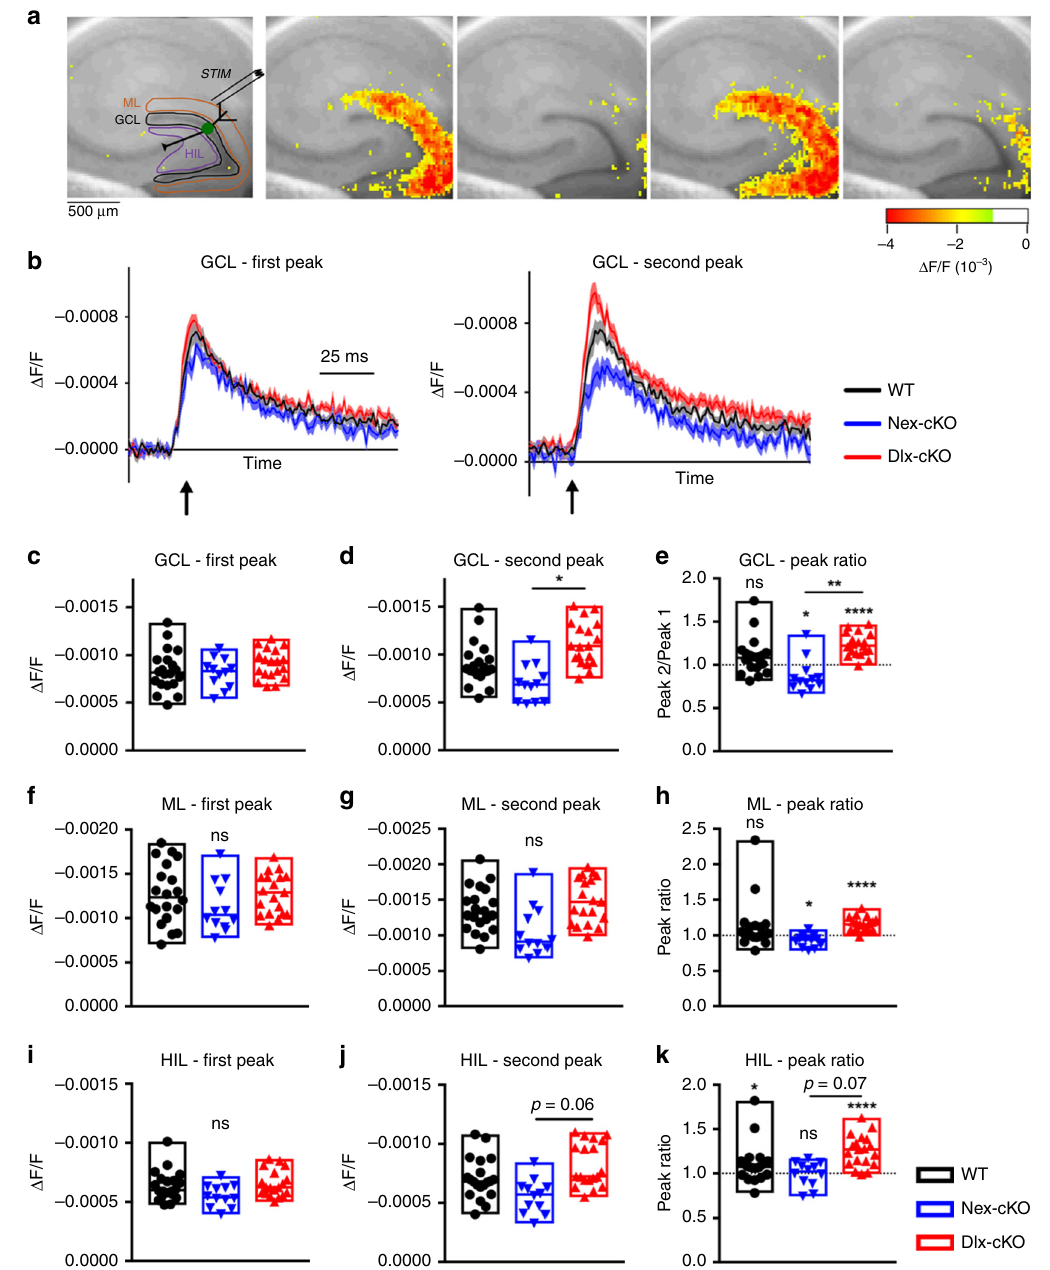
Fig. 2 Dlx-cKO mice show aberrant paired-pulse facilitation. a Schematic of voltage-sensitive dye imaging (VSDI) showing the site of stimulation at the perforant path and regions of interest used for quantitative analysis (GCL, granule cell layer; ML, molecular layer; HIL, hilus). Snapshots of VSDI responses in a wild-type slice, from left to right: baseline, peak response to fi rst stimulus, baseline immediately prior to second stimulus, peak response to second stimulus, 100 ms after second peak response (200 μ A x 2 stimuli, with 200 ms inter-stimulus interval). b Averaged VSDI responses ( Δ F / F ) in the GCL for WT, Nex-cKO, and Dlx-cKO mice in response to each of the two stimuli. Depolarization (decrease in Δ F / F ) is displayed as an upward signal, while hyperpolarization (increase in Δ F / F ) is displayed as a downward signal. Error envelopes represent mean + / − s.e.m. c Peak amplitudes of the GCL response to the fi rst stimulus were not different between WT, Nex-cKO, and Dlx-cKO mice (linear mixed effect analysis). d Peak amplitudes of the GCL response to the second stimulus were signi fi cantly different between Nex-cKO and Dlx-cKO mice (linear mixed effect analysis with Tukey ’ s correction for multiple comparisons). e Ratios of peak responses in the GCL. Nex-cKO slices showed signi fi cant paired-pulse depression, whereas Dlx-cKO slices showed signi fi cant paired-pulse facilitation (one-sample t -tests for each of WT, Nex-cKO, and Dlx-cKO, two-tailed). Dlx-cKO also showed signi fi cantly increased paired-pulse ratio in comparison to Nex-cKO (linear mixed effect analysis with Tukey ’ s correction for multiple comparisons). f – k Averaged VSDI responses ( Δ F / F ) in the ML and HIL for WT, Nex-cKO, and Dlx-cKO mice in response to each of the two stimuli (linear mixed effect analysis). h Peak ratios in ML (one-sample t -test or Wilcoxon signed-rank test, two-tailed). k Peak ratios in HIL (one-sample t -test or Wilcoxon signed-rank test, two-tailed). For all experiments, n = 20 slices/5 mice for WT, n = 12 slices/4 mice for Nex-cKO, and n = 19 slices/5 mice for Dlx-cKO. * p < 0.05, **** p < 0.0001. Source data are provided as a Source Data fi